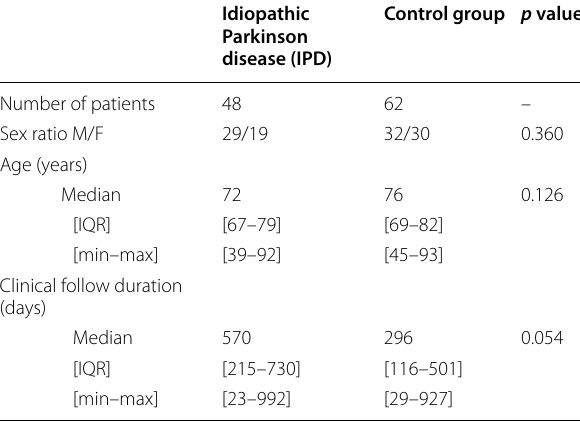
Table 1 Patients’